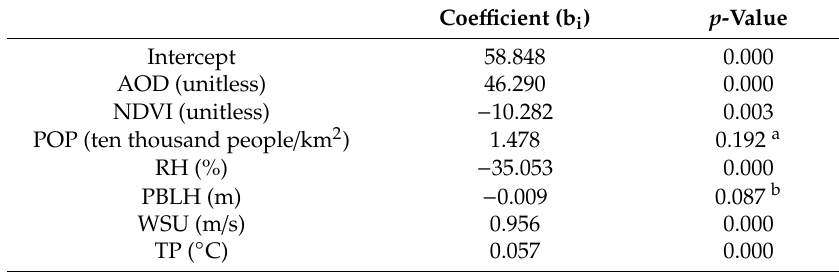
Table 2. Fixed e ff ect of the liner mixed e ff ects (LME) model. NDVI—normalized di ff erence vegetation index; POP—population density; RH—relative humidity; PBLH—planetary boundary layer height; WSU—meridional component wind speed U;